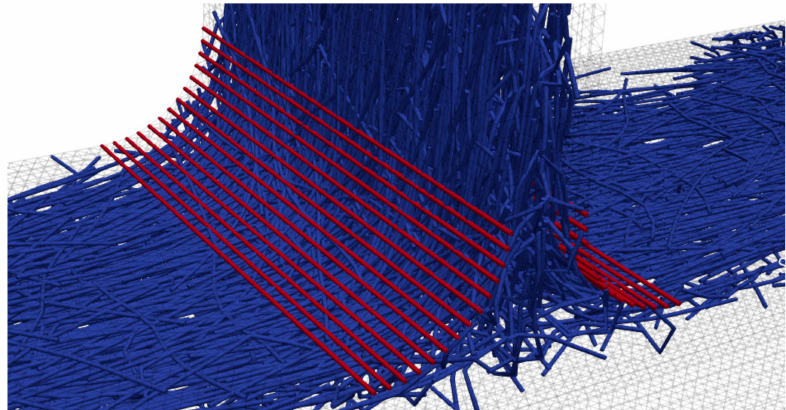
Figure 5. Increased boundary conditions shown in red. Note: Fiber radius is shown as larger for illustration purposes.